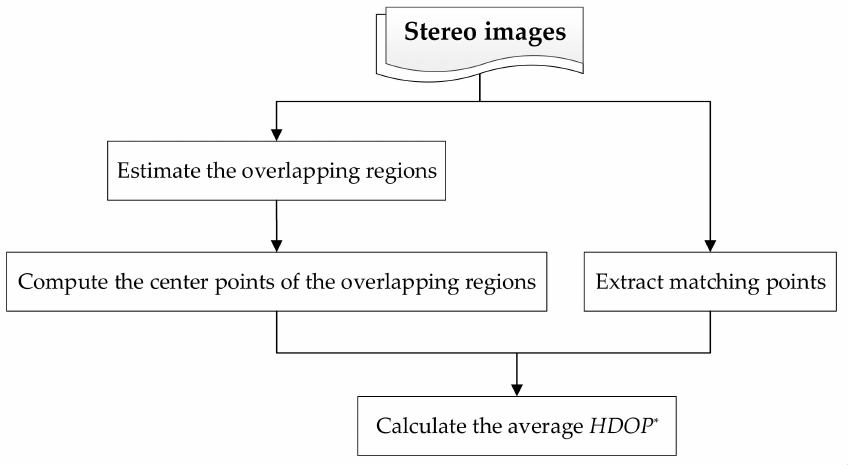
Figure 2. The flow chart of the proposed